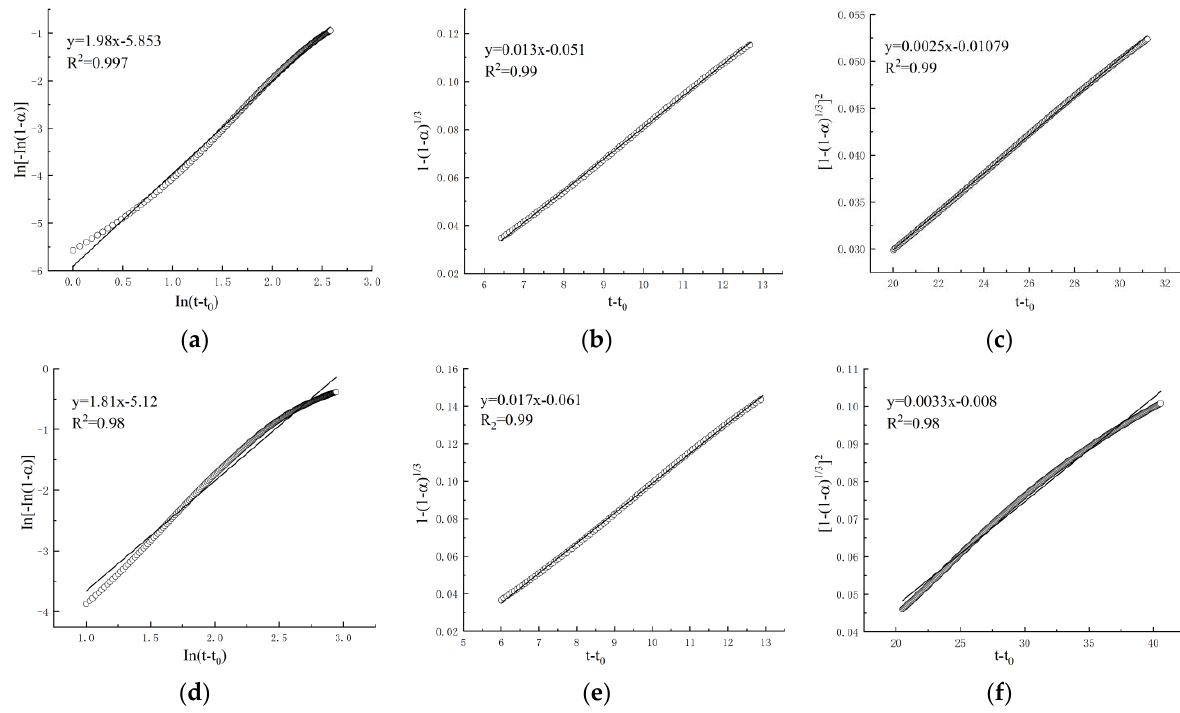
Figure 3. Cement hydration rate and heat of hydration curve.